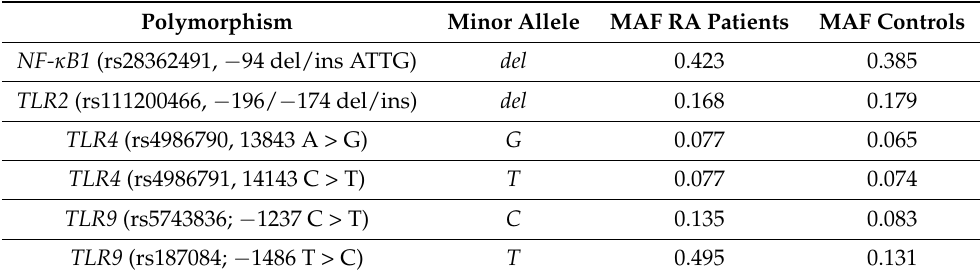
Table 2. Minor allele frequencies (MAFs) of the polymorphisms studied in Polish patients with rheumatoid arthritis and healthy